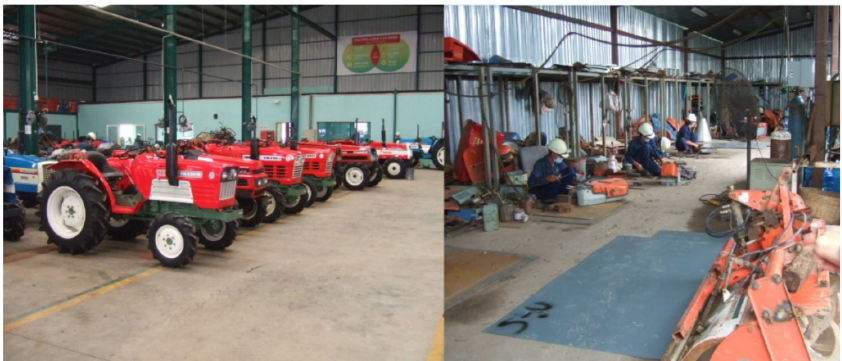
Figure 11. A tractor reconditioning company in Long An province. Source: Photo was taken by